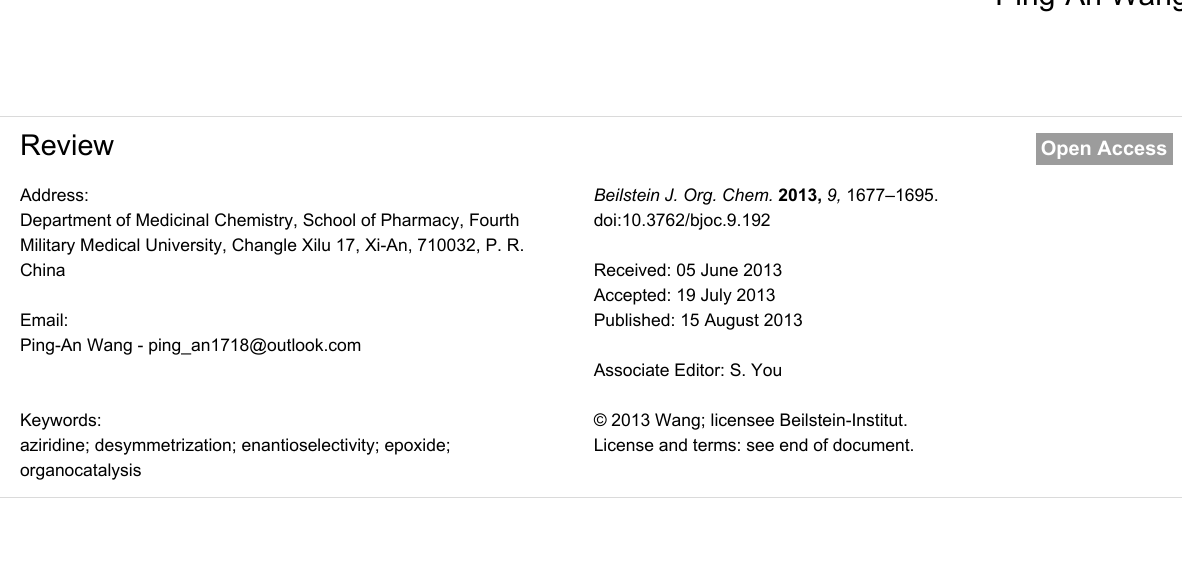
renaissance and the golden age of organocatalyzed reactions [7-9]. Aziridines and epoxides are quite reactive due to the large tension of their three-membered ring system. The enantioselec- tive ring-opening of aziridines [10-12] or epoxides [13-15] provides facile access to various chiral amines and alcohols and their derivatives with two adjacent stereogenic centers,